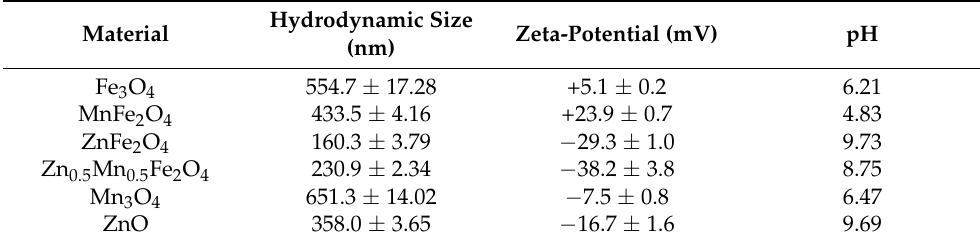
Table 3. Hydrodynamic size and zeta-potential for all